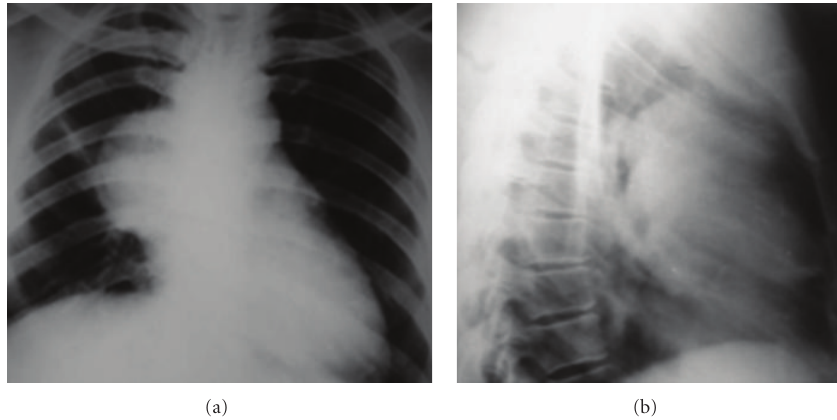
Figure 1: Chest radiographs, PA (a) and lateral views (b) show a well-defined mass in the anterior mediastinum.